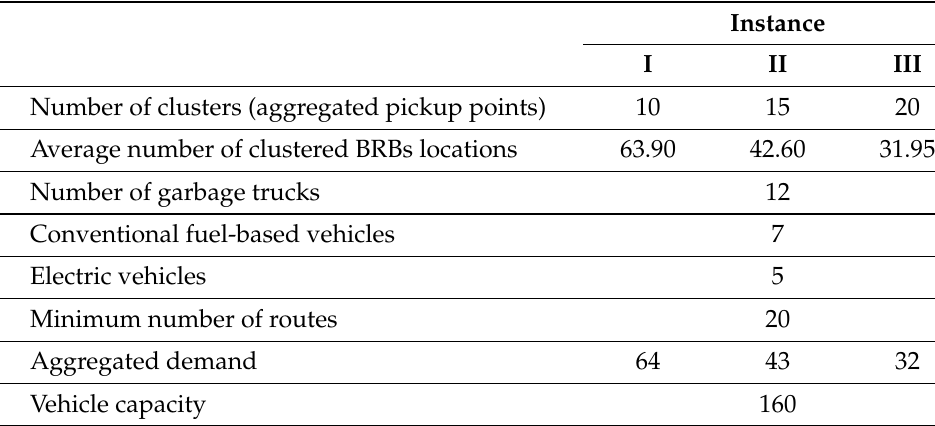
Table 3. Parameters used in computational experiments.